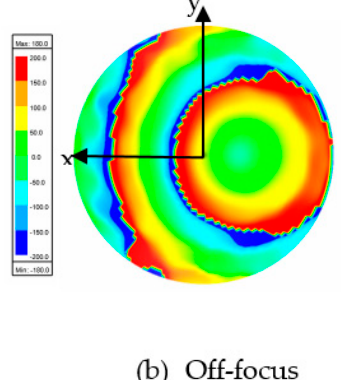
Figure 22. Electric intensity distribution.